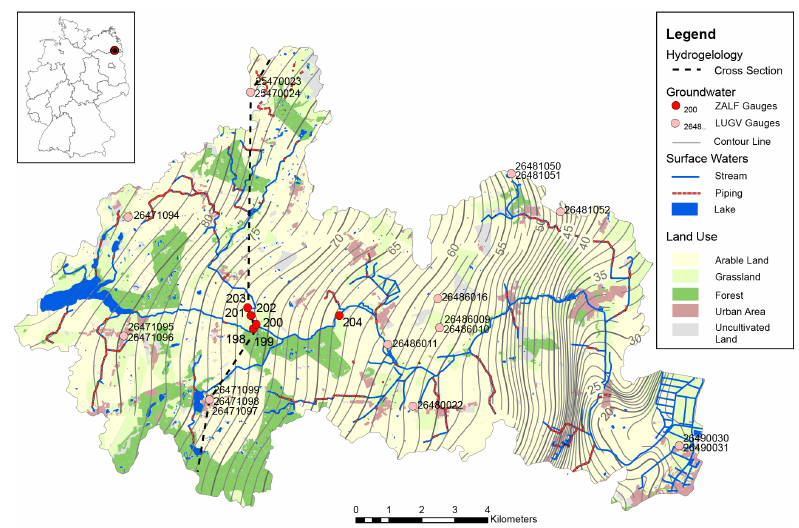
Figure 1. Shape and location of the Quillow catchment, the site of available groundwater observation wells, regional groundwater heads of the confined Weichselian–Saalian aquifer and land use/land cover over the region; transect of the regional geological profile